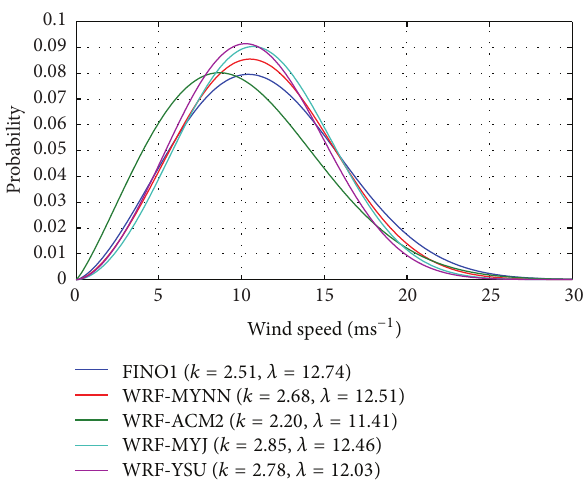
Figure 10: Weibull distribution based on March 2005 data from the FINO1 measurements and the WRF PBL runs (ACM2, YSU, MYJ, and MYNN) at 100m